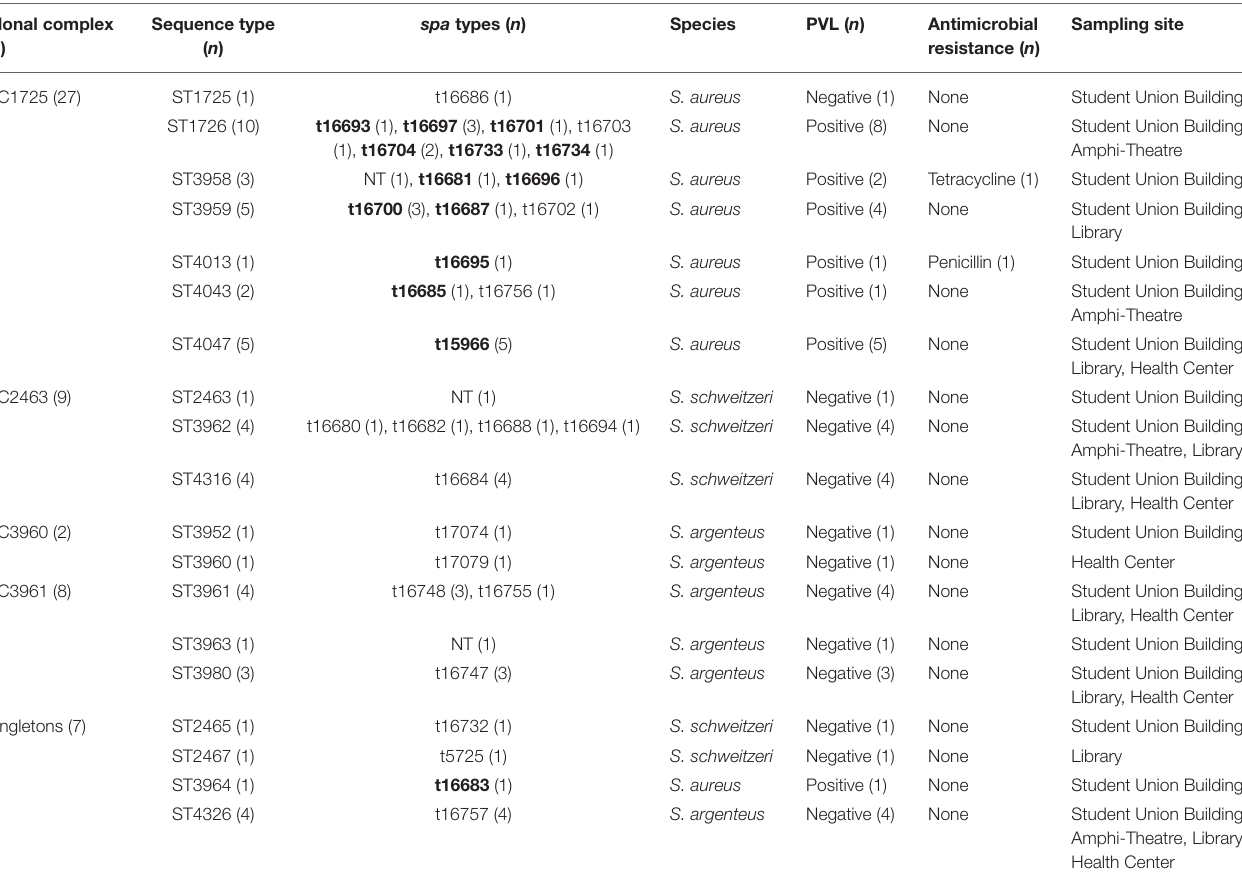
TABLE 1 | Molecular characteristics of Staphylococcus aureus complex from bats, Nigeria, 2015–2016. Clonal complex ( n